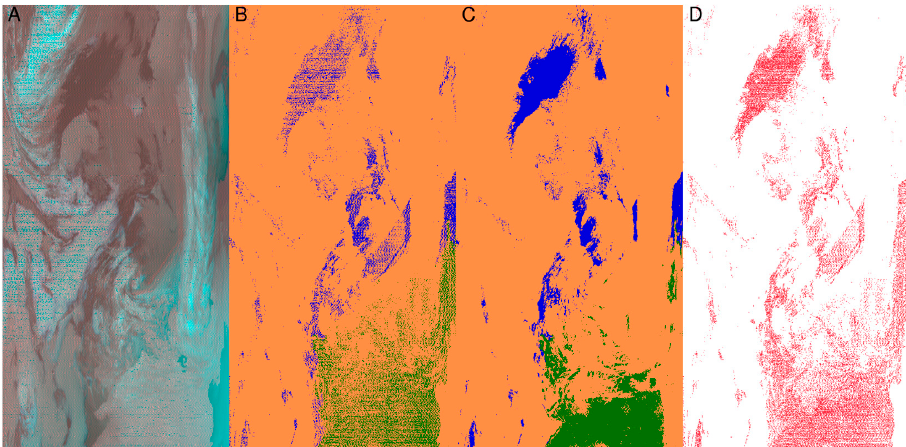
Figure 2. Channel 3b noise effects in a portion of an AVHRR GAC orbit near Antarctica (Test Area 2 in Figure 1) from 1 January 1983 (near 00 UTC). ( A ) colour composite image based on brightness temperatures of the three AVHRR infrared channels 3b, 4 and 5 at 3.7, 11 and 12 microns, respectively; ( B ) cloud mask product for the same image (orange is cloudy, blue is cloudfree water and green is land (including snow covered land); ( C ) cloud mask product after using the channel 3b noise filter; ( D ) difference plot where red indicates either removal or adding of clouds.